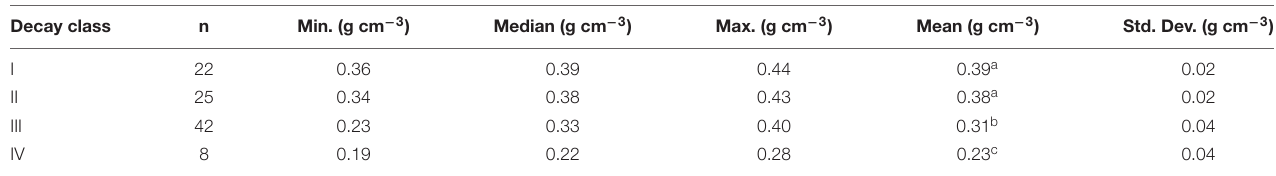
TABLE 3 | Summary statistics for wood density and decay class